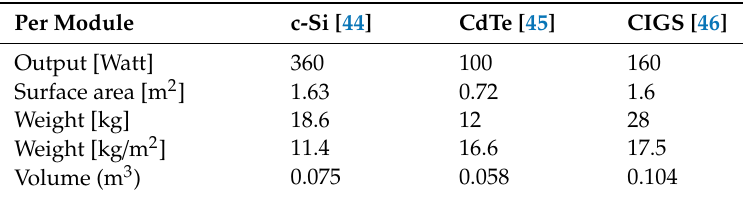
Table 2. The specifications of the PV technologies.